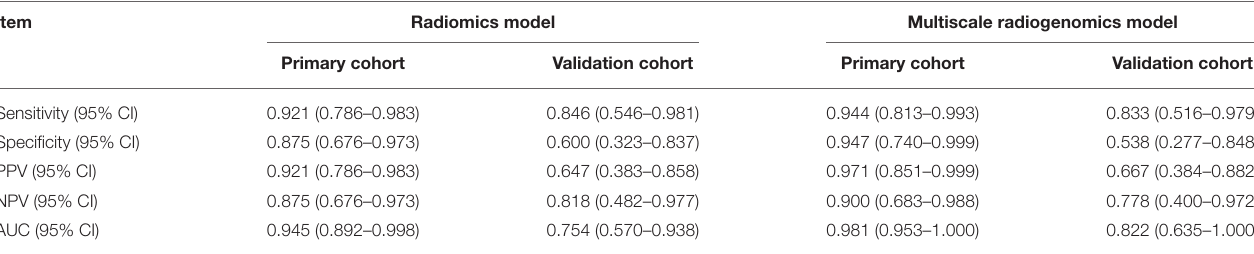
TABLE 2 | Performance of the radiomics model and multiscale radiogenomics model in primary and validation cohorts.